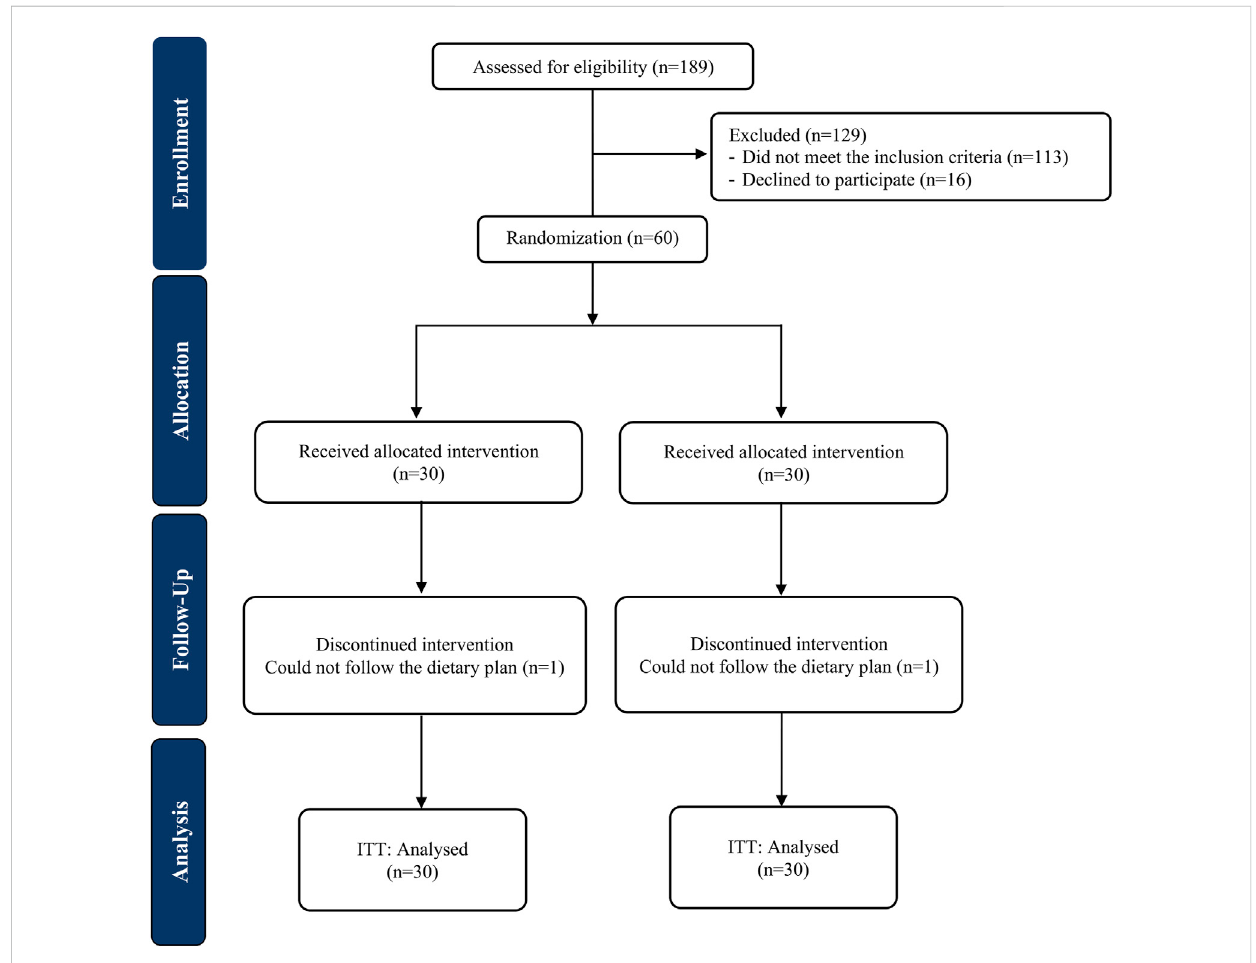
FIGURE 1 Study fl ow diagram (ITT, Intention to